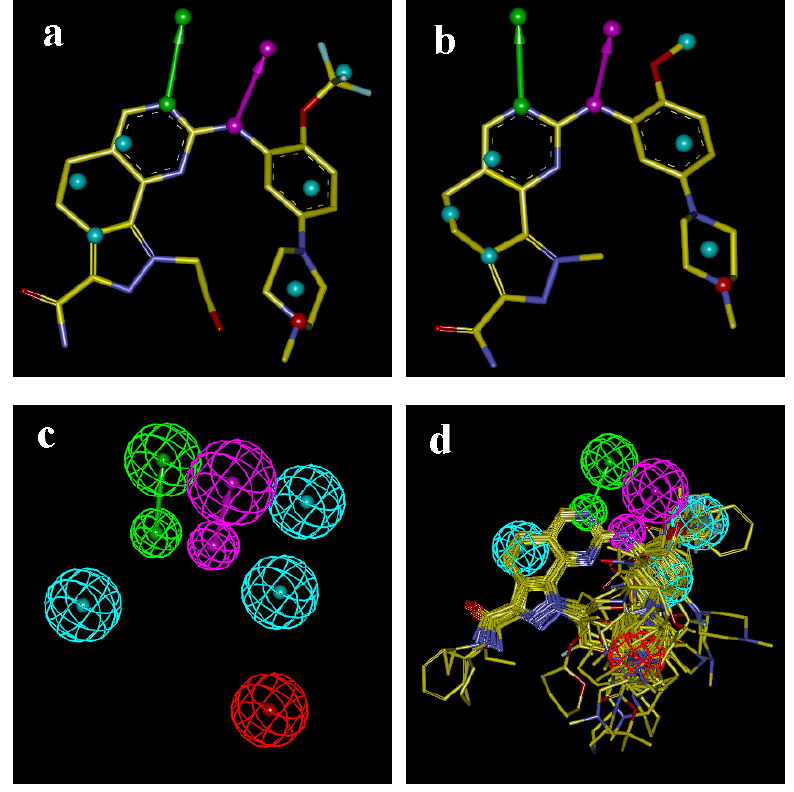
Figure 4. ( a ) Pharmacophore model derived from 2YAC; ( b ) Pharmacophore model derived from 3KB7; ( c ) The merged model; ( d ) The compounds alignment based on the merged model. Features are color-coded with magenta for hydrogen-bond donor, green for hydrogen-bond acceptor, light-blue for hydrophobic, red for ionizable